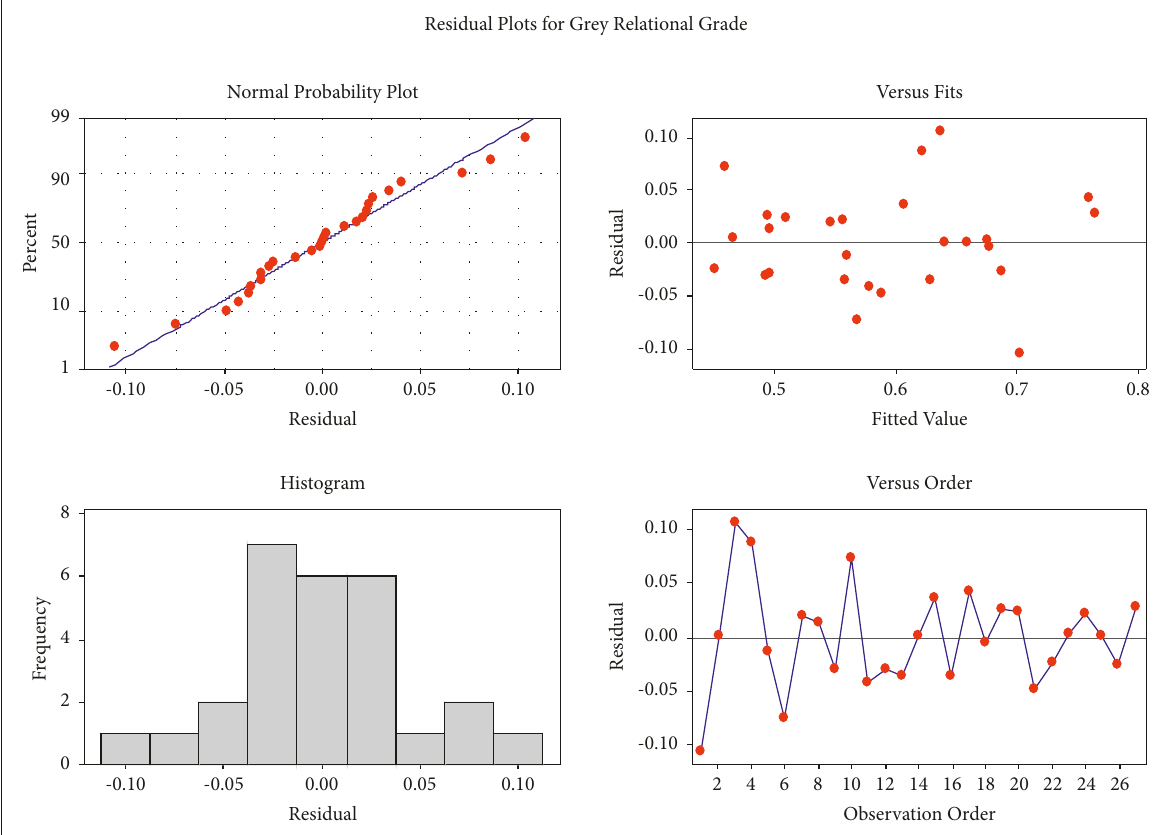
Figure 12: Residual plots for overall grey relational grade